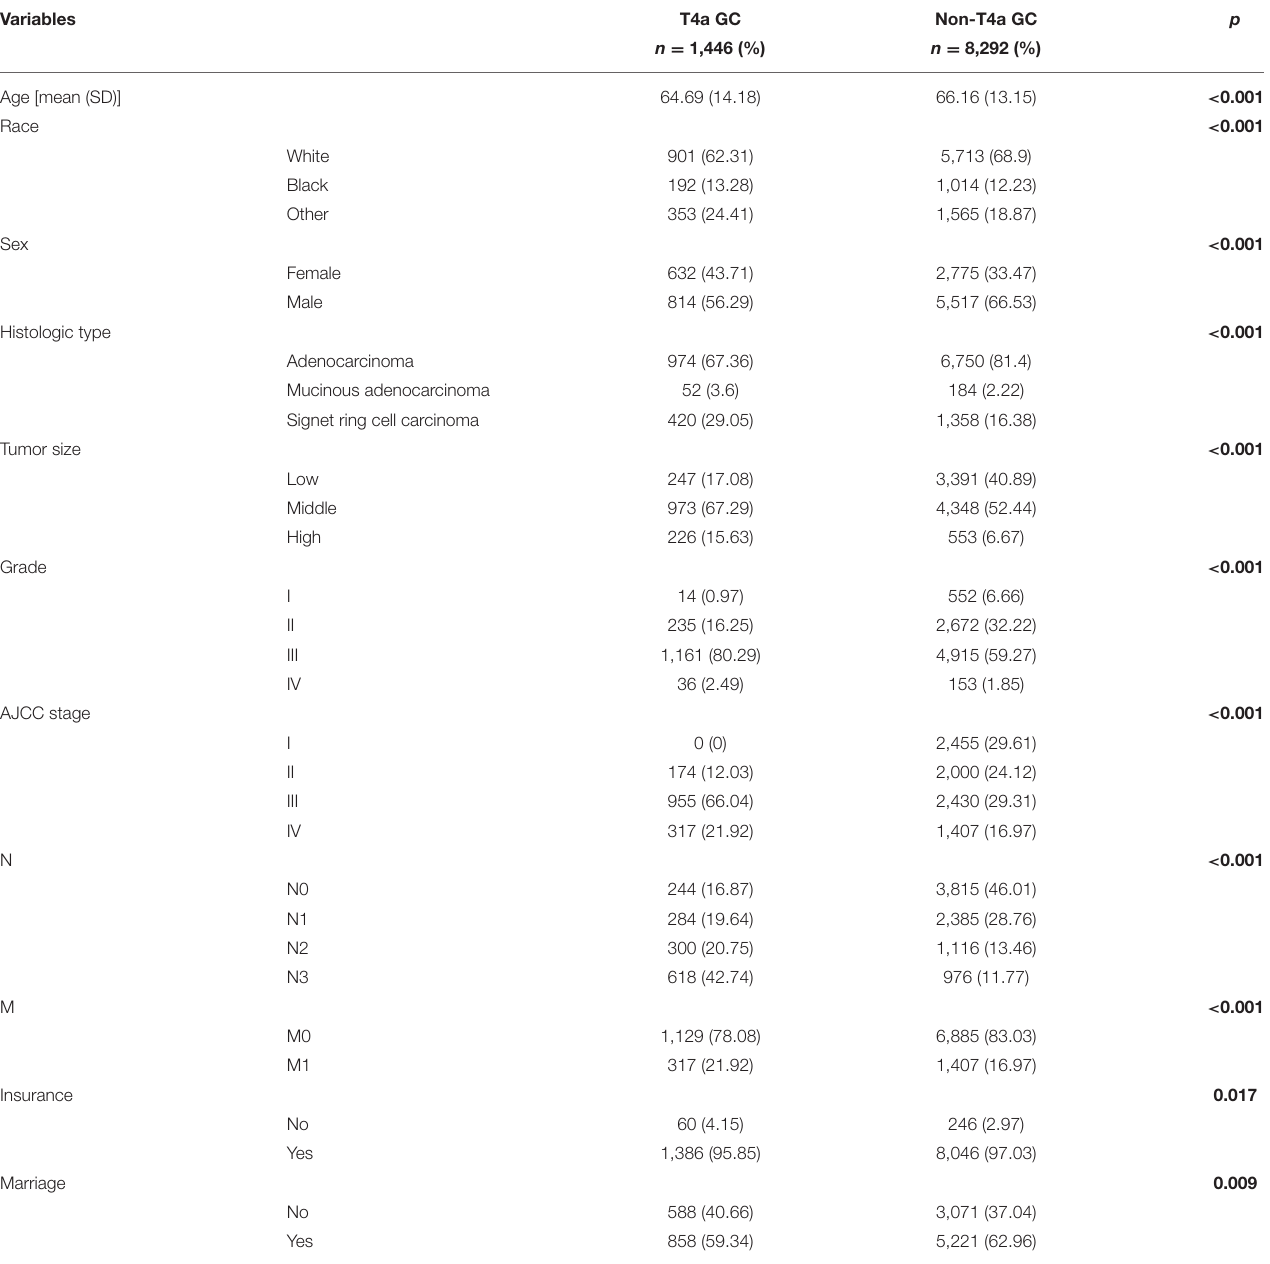
TABLE 1 | Clinical characteristics between patients with T4a and non-T4a GC.